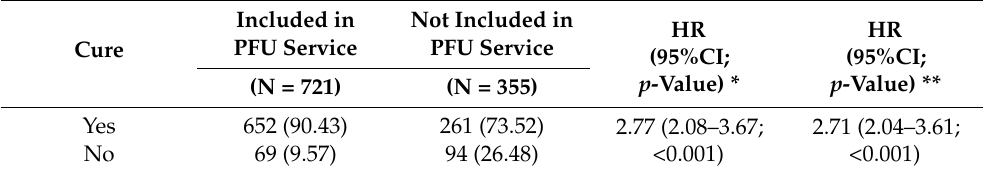
Table 2. Comparison of the incidence of cure among people with tuberculosis included or